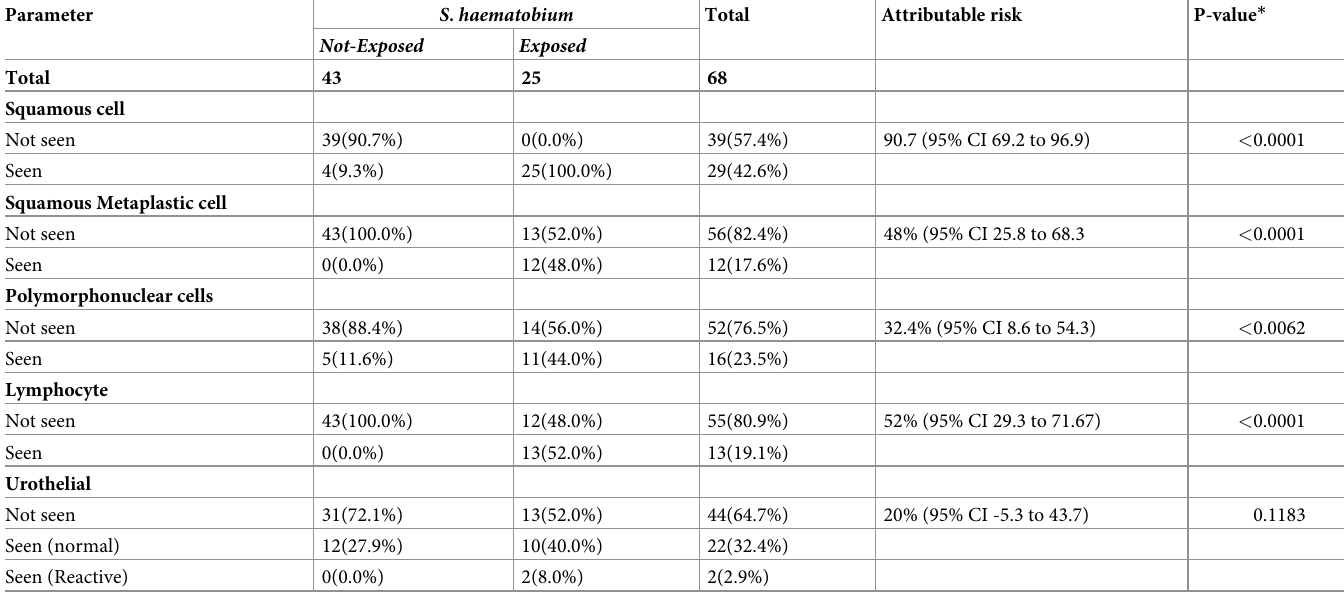
Fig 1. Cellular changes in S . haematobium positive urine samples. Grading of S . haematobium positivity: + ( < 5 S . haematobium ova per high power field), ++ (5–10 ova per high power field), +++ ( > 10 ova per high power field). https://doi.org/10.1371/journal.pone.0278202.g001 Table 1. Cellular changes in the smears of SH negative urine